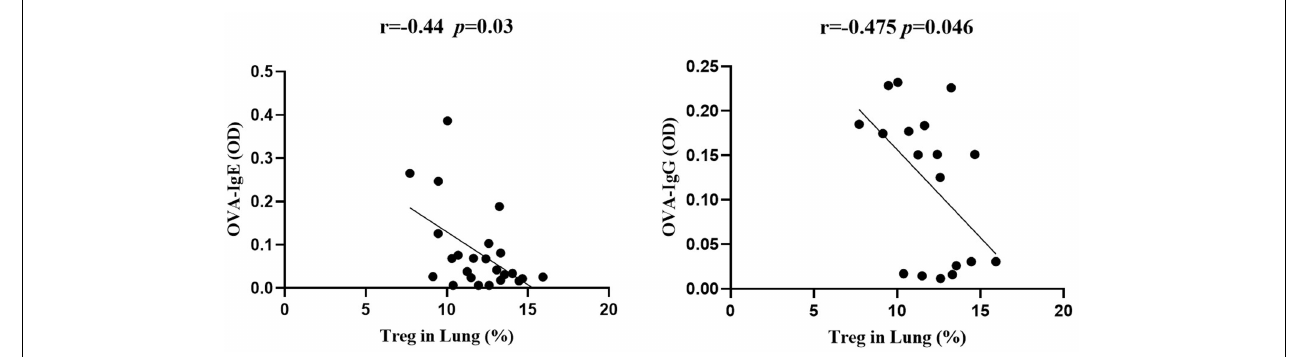
FIGURE 6 | The frequency of Treg cells in lung negatively correlated with OVA-specific IgE and IgG. Correlation analysis between Treg cell frequency in lung and the optical density values of OVA-specific IgE (left) and IgG (right) in serum ( n = 5 or 6 mice per group, experiment performed twice).